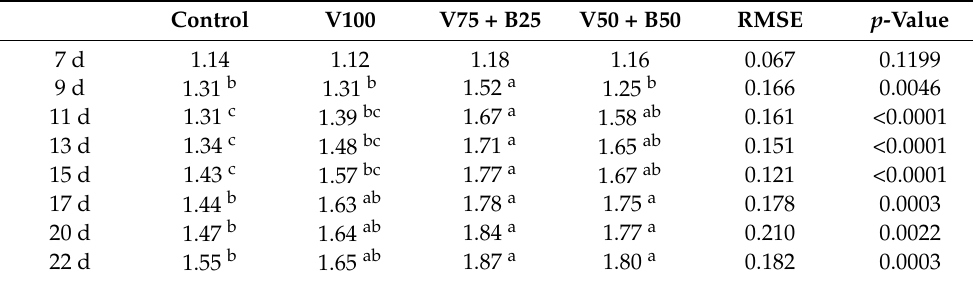
Table 3. Body length (cm) of black soldier fly larvae from 7 to 22 days of age. Control